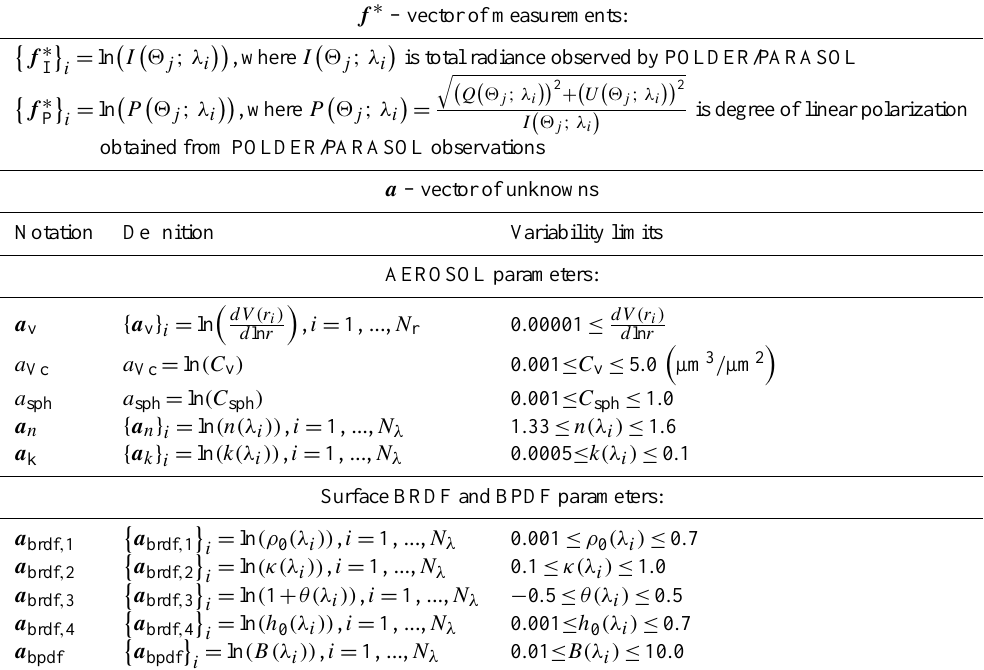
Table 2. Definition of the measurement vector f ∗ and the vector of unknowns a . f ∗ – vector of